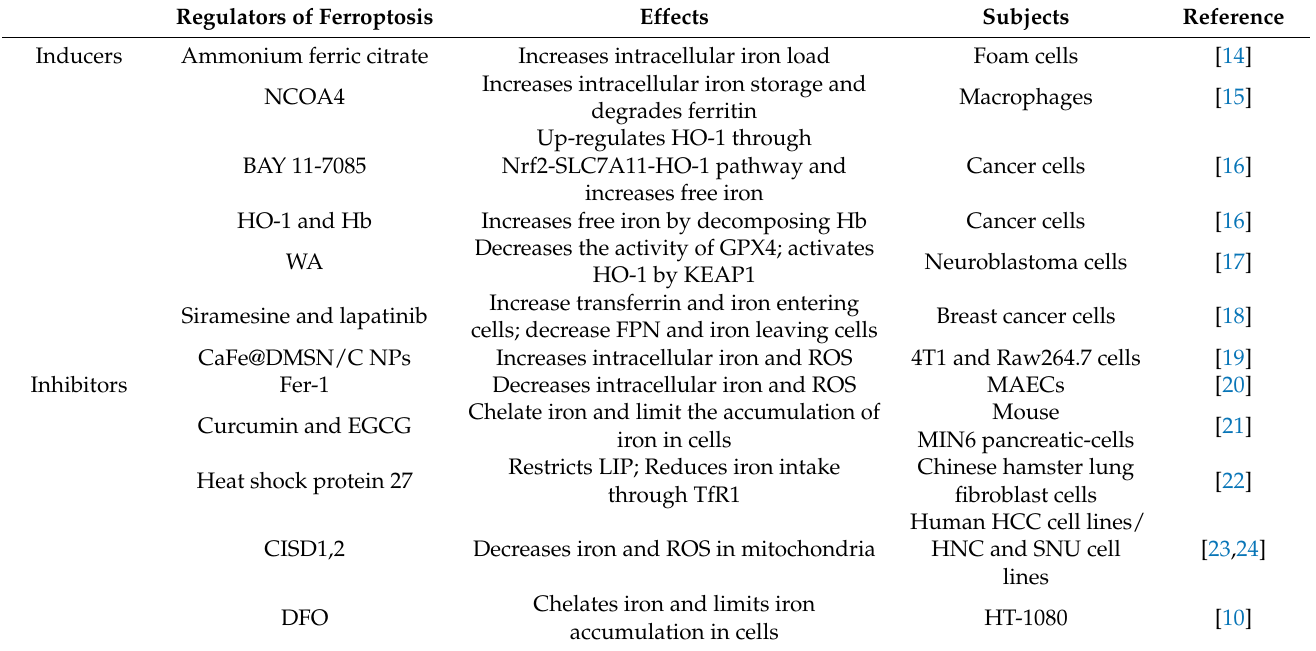
Table 2. Inducers and inhibitors of ferroptosis associated with iron